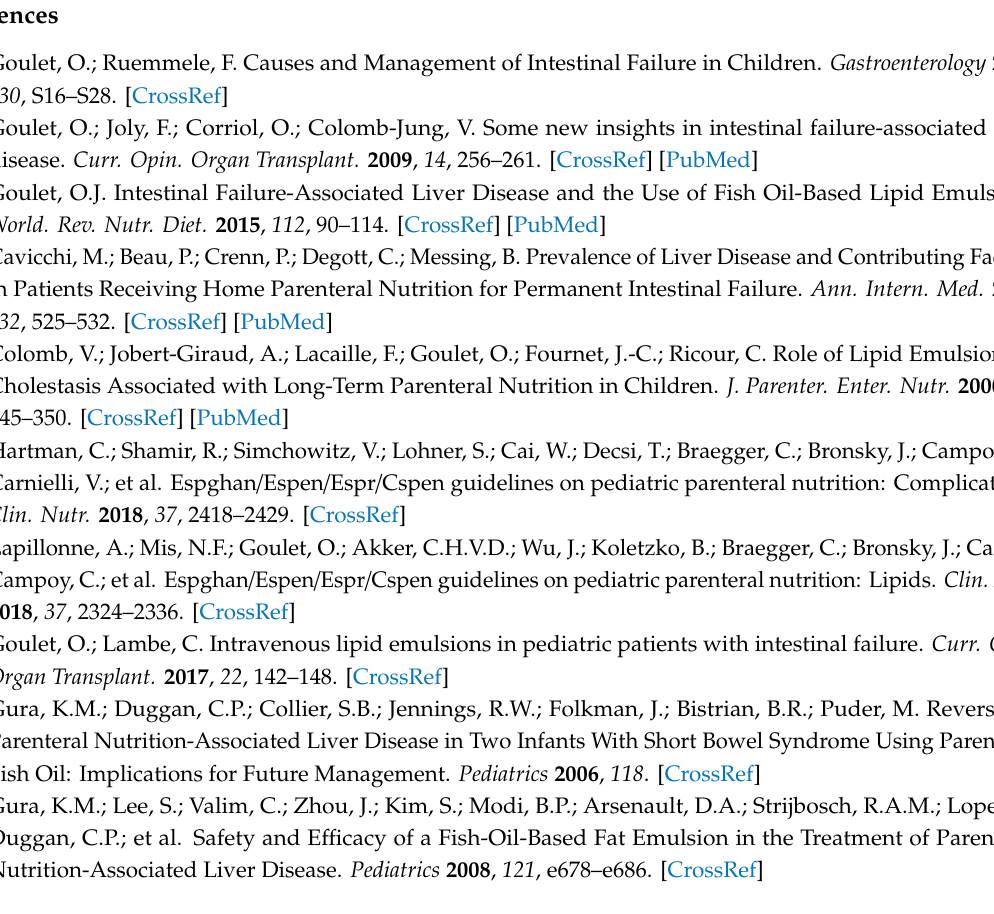
Table S1: Quality requirements / criteria of Transient Elastography (Fibroscan, Echosens ® , Paris, France); Table S2: PUFAs concentrations in plasma and erythrocyte membranes in HPN patients treated with SMOF ® or Clinoleic ® and in healthy children; Table S3: PUFAs concentrations on plasma and erythrocyte membranes in HPN patients treated with SMOF ® or Clinoleic ® ; Table S4: PUFAs concentrations on plasma and erythrocyte membranes in HPN Patients treated with SMOF ® and in healthy children; Table S5: PUFAs concentrations on plasma and erythrocyte membrane profile in HPN Patients treated with Clinoleic ® and in healthy children; Table S6: PUFAs concentrations in plasma and red blood cell membranes of HPN patients treated with SMOF ® and Clinoleic ® divided by age groups; Table S7: Anthropometrics values; Table S8: Laboratory tests: biochemical indices of inflammation, antioxidants, renal and liver function, bone, nutritional as well as vitamin and oligomineral status in patients treated with SMOF ® or Clinoleic ® ; Figure S1: Correlation between plasma and RBC PUFAs